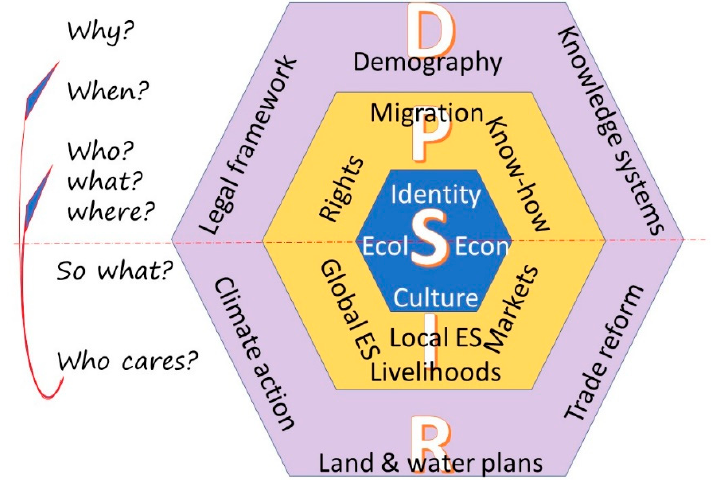
Figure 4. State variables and processes relevant for change in eco-hydrological-social systems in the forest–water–people nexus grouped in a DPSIR (drivers, pressures, system state, impacts, responses) framework.